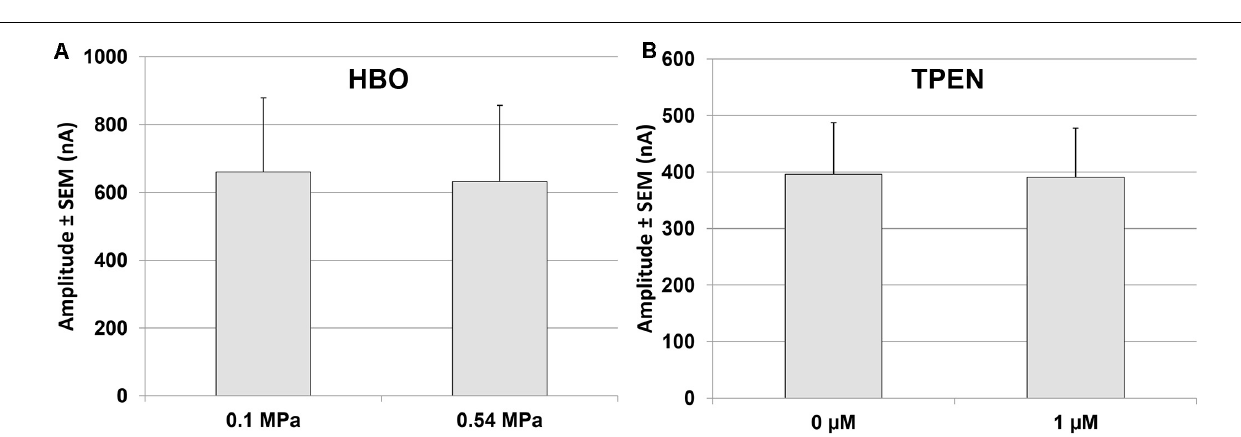
FIGURE 5 | Quantitative analysis of GluN1-1a + GluN2B currents in HBO and with TPEN. (A) Current amplitude expressed as mean ± SEM in control (0.1 MPa) and 0.54 MPa O 2 ( n = 7). (B) Current amplitude expressed as mean ± SEM with 0 µ M or 1 µ M TPEN in control (0.1 MPa) ( n = 5). No statistically significant difference was found for either